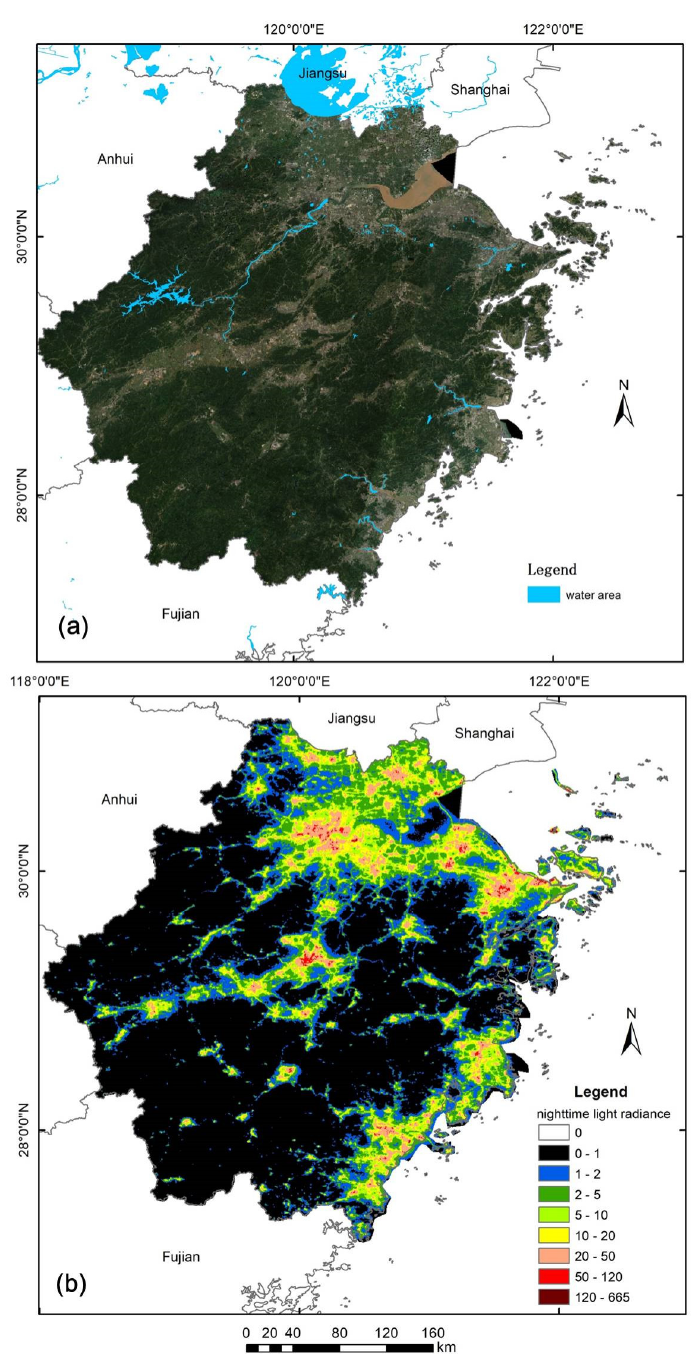
Figure 2. ( a ) The Sentinel-2 satellite true color composite image and ( b ) the VIIRS monthly average nighttime light radiance of Zhejiang Province.